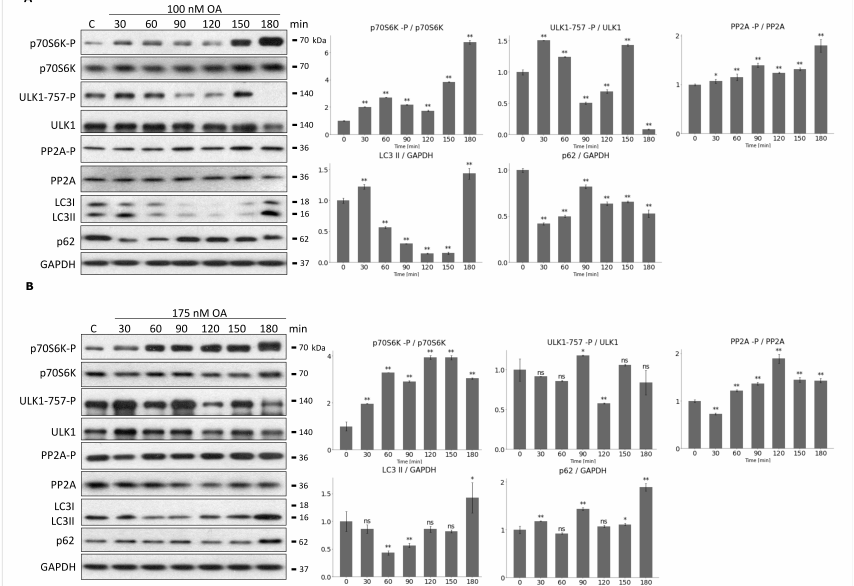
Figure 7. Prolonged OA treatment results in oscillation of PP2A-mTORC1-ULK1 controlled autophagy. HEK293T cells were denoted in time after ( A ) 100 nM or ( B ) 175 nM OA treatment. ( A , B , panel left ) The markers of ULK1 (ULK1-757-P), PP2A (PP2A-P), and mTORC1 (p70S6K-P) were followed by immunoblotting. GAPDH was used as loading control. ( A , B , panel right ) Densitometry data represent the intensity of ULK1-757-P normalized for total level of ULK1, PP2A-P normalized for total level of PP2A and p70S6K-P normalized for total level of p70S6K. For each of the experiments, three independent measurements were carried out. Error bars represent standard deviation asterisks indicate statistically significant difference from the control: ns—nonsignificant; *— p < 0.05; **— p <